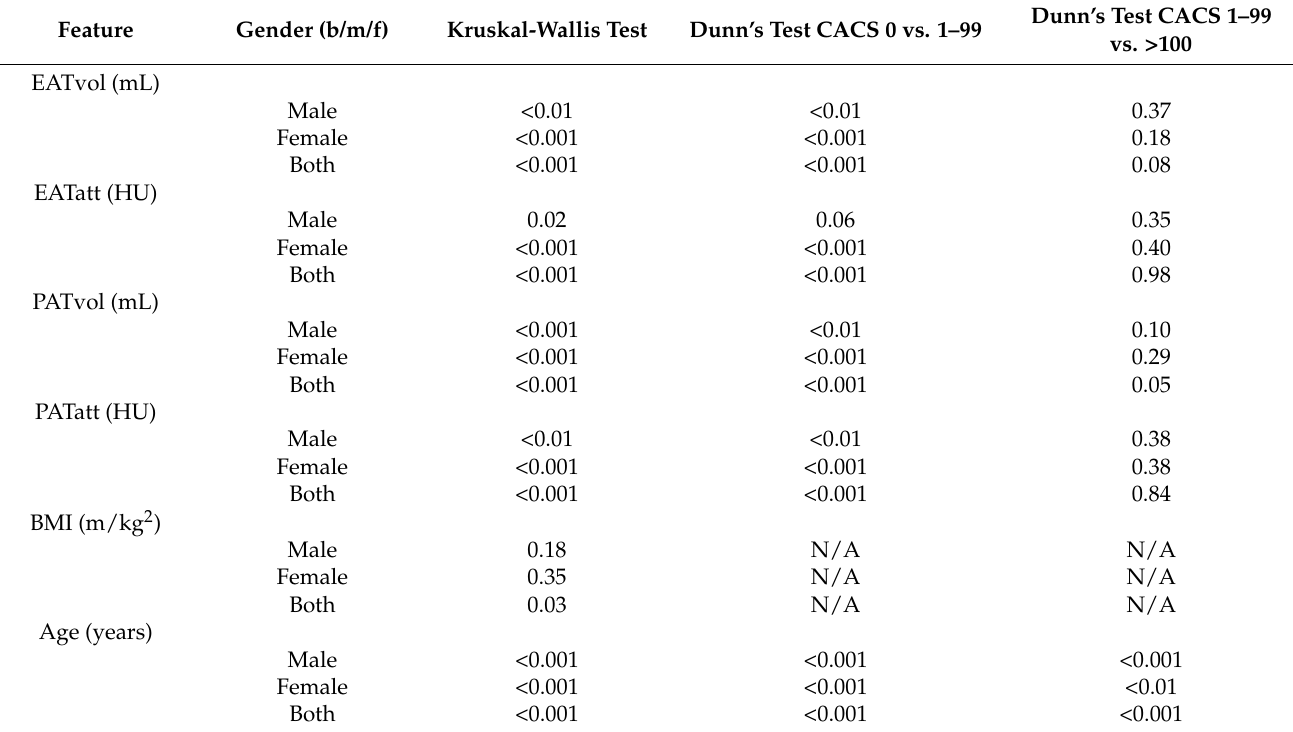
Table 3. Inter-group comparison of CACS groups itemized into gender groups (both/male/female) regarding their significance. The results of Dunn’s Test are stated as not applicable (N/A) when the Kruskal-Wallis test does not reach the significance